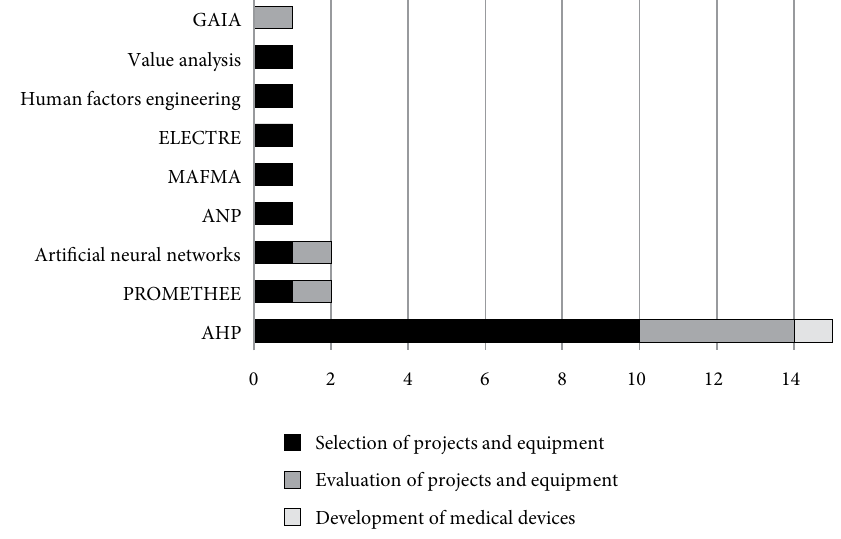
Fig. Use of MCDA methods for management of medical